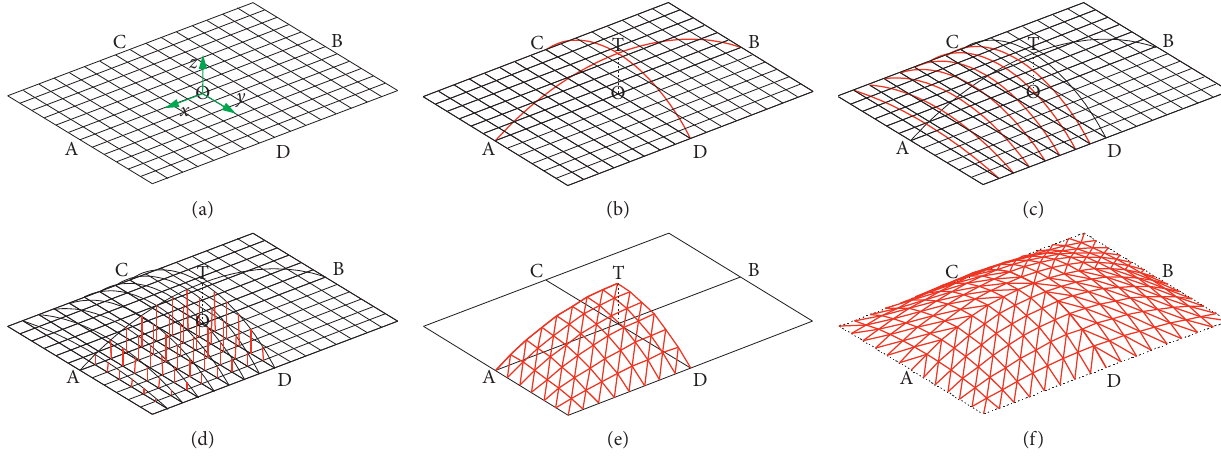
Figure 3: Geometrical modeling procedure of roof. (a) 1st step, (b) 2nd step, (c) 3rd step, (d) 4th step, (e) 5th step, and (e) 6th step.